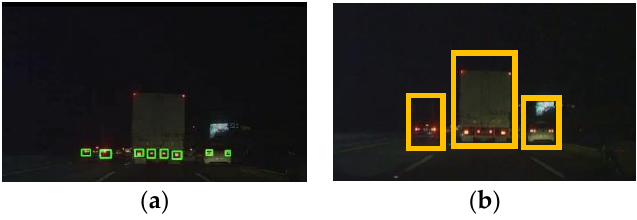
Figure 8. Locating Regions-of-Interest ( a ) taillights location ( b ) initial estimations of ROI.